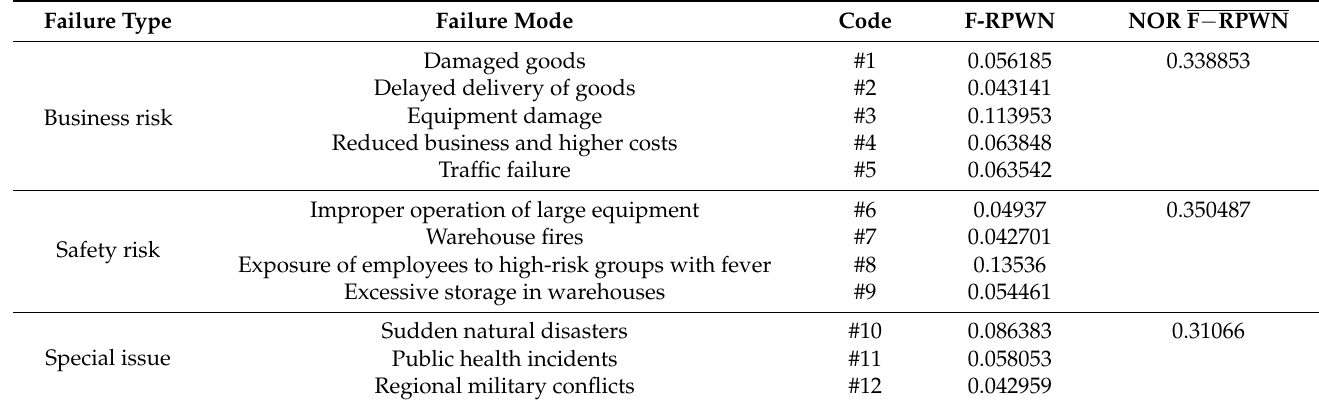
Table 8. F-RPWN and F − RPWN of each failure type and RPWN of each failure